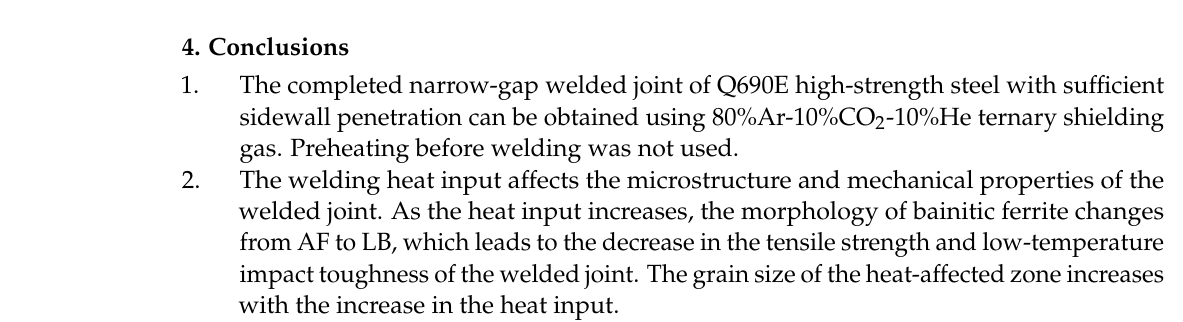
Figure 8. Microstructure of the welded joint of 155 mm ‐ thick plates: ( a ) WZ; ( b ) CG ‐ HAZ; ( c ) FG ‐ HAZ.